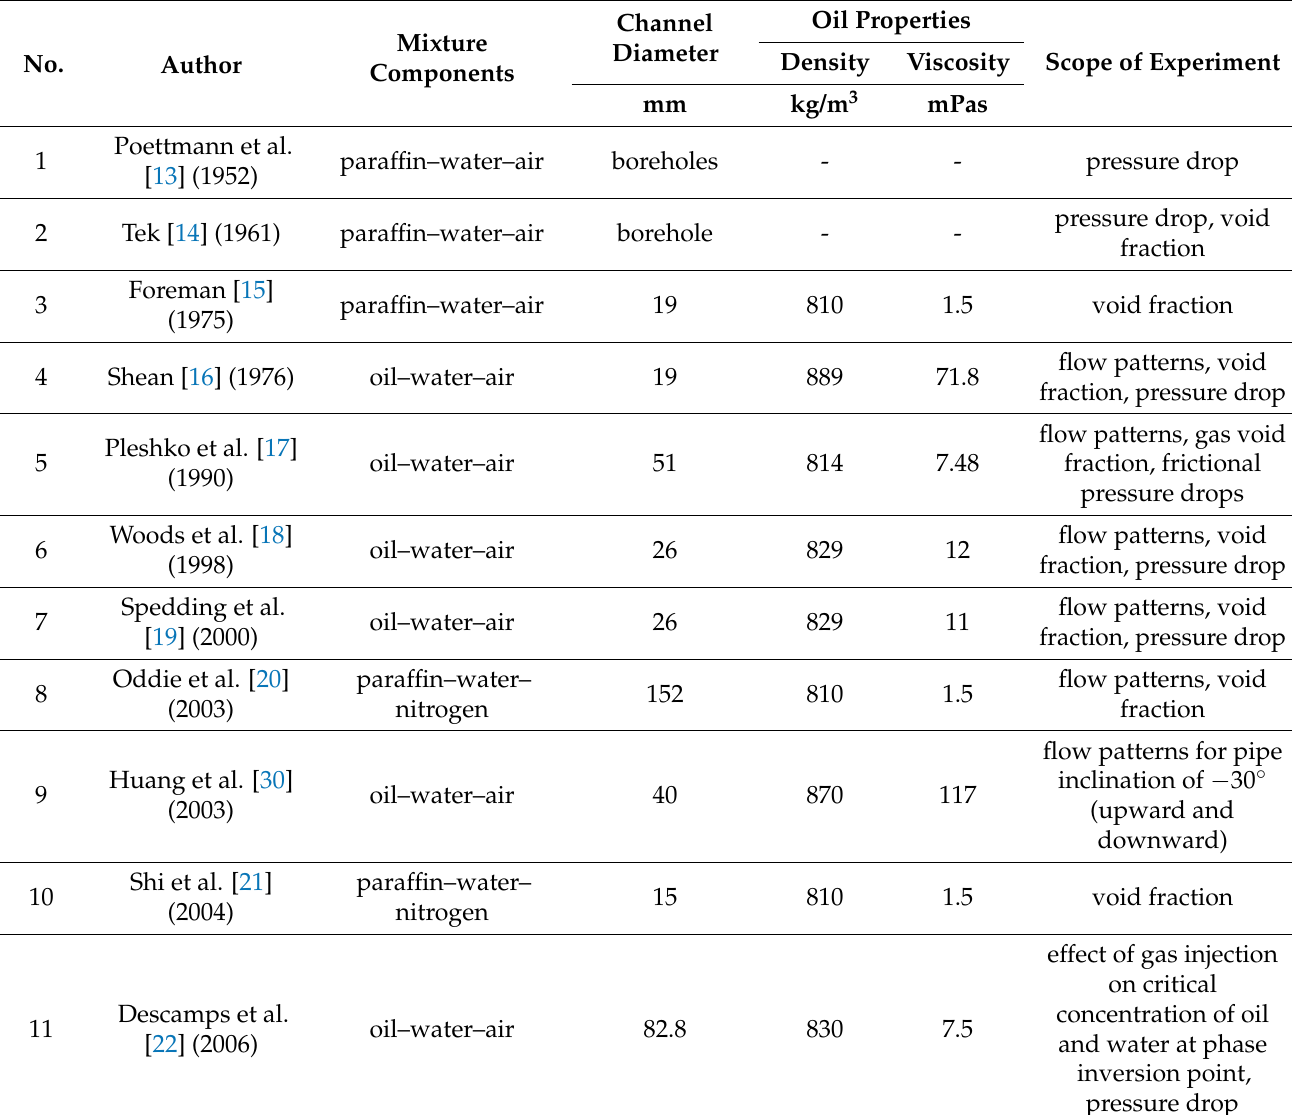
Table 1. Summary of research into the hydrodynamics of upward three-phase gas–liquid–liquid flow in vertical pipes.